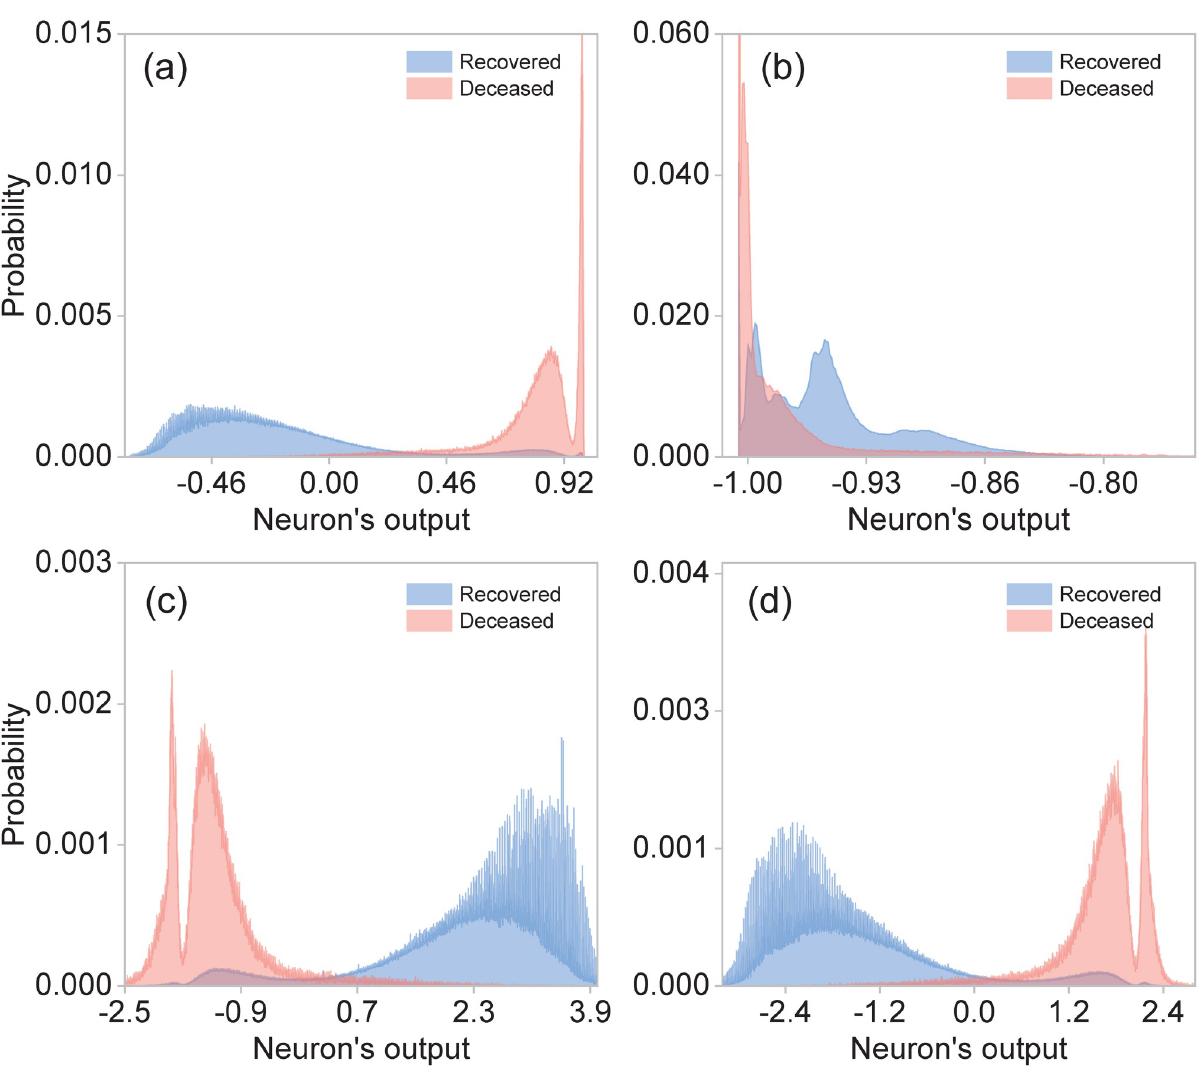
Fig 3. Statistical distributions for deceased (red) and recovered (blue) patients built from the outputs of: (a) neuron-1 in layer 1, (b) neuron-2 in layer 1, (c) neuron-1 in layer 2 and (d) neuron-2 in layer 2.